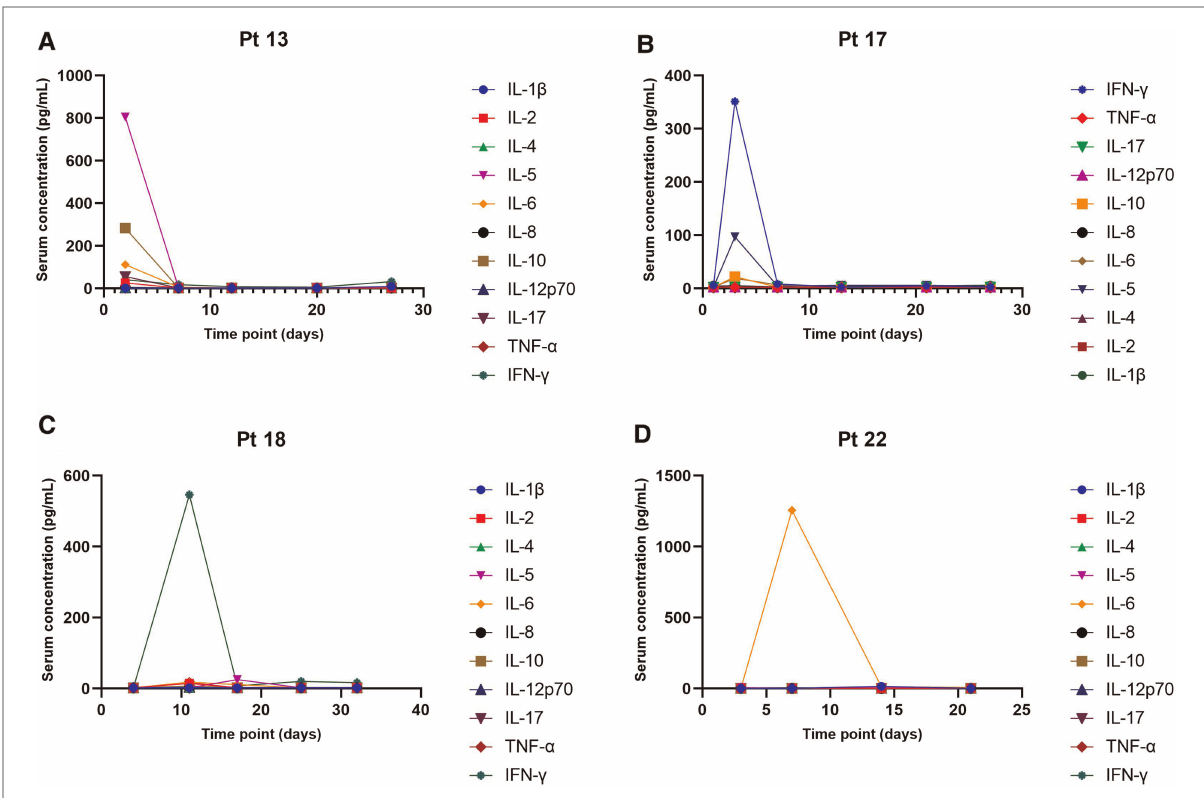
FIGURE 4 Serum concentrations of cytokines. ( A ) Patient 13 , chemotherapy-eligible, 7-month follow-up. ( B ) Patient 17 , chemotherapy-eligible, 2-month follow-up. ( C ) Patient 18 , chemotherapy-eligible, with 1 month of follow-up. ( D ) Patient 22 , chemotherapy-eligible, with 1 month of